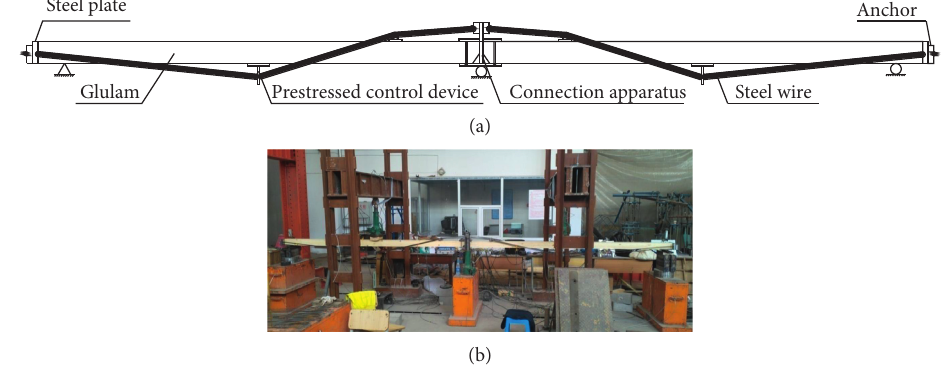
Figure 1: Prestressed Glulam continuous beam. (a) Details of the specimen. (b) Figure of the specimen.